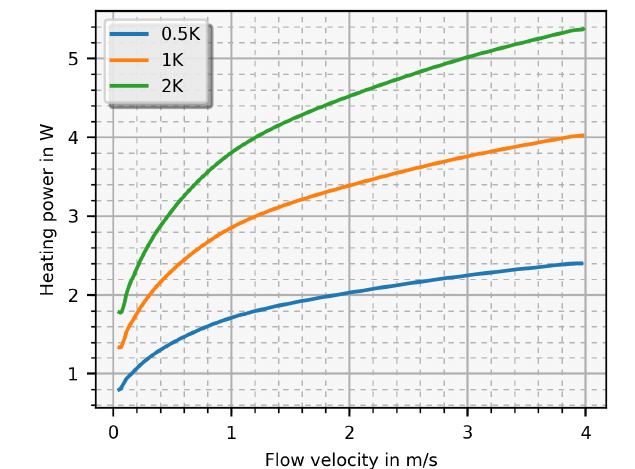
Figure 5. Simulated heating power versus the the flow velocity for three preselected temperature differences ( ∆ T ) with water as test